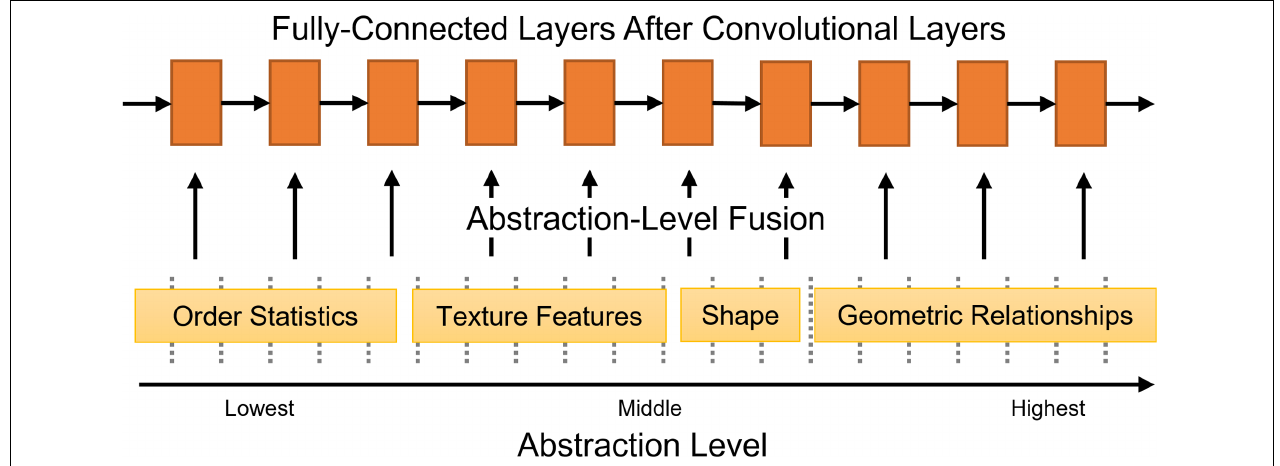
FIGURE 3 | A general overview of the idea of Abstraction-Level Framing. After the convolutional, filtering portion of a convolutional neural network, each fully connected layer receives additional features at increasing levels of abstraction.